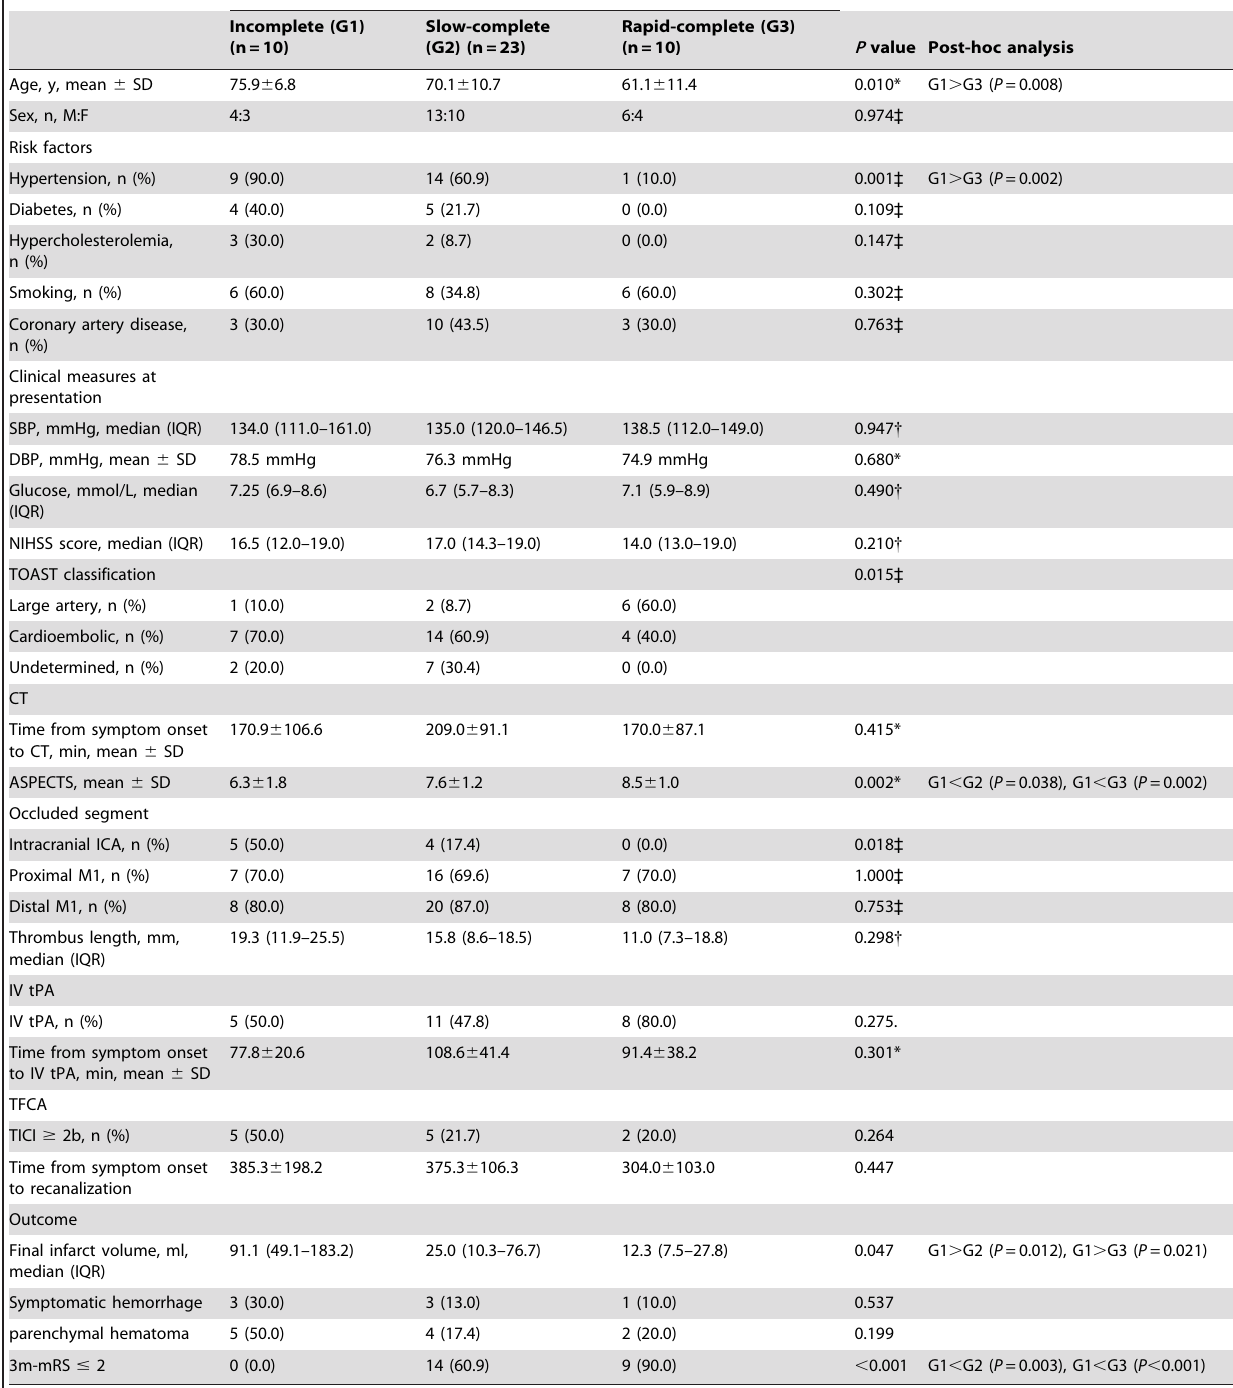
Table 1. Demographic characteristics according to dual-phase collateral